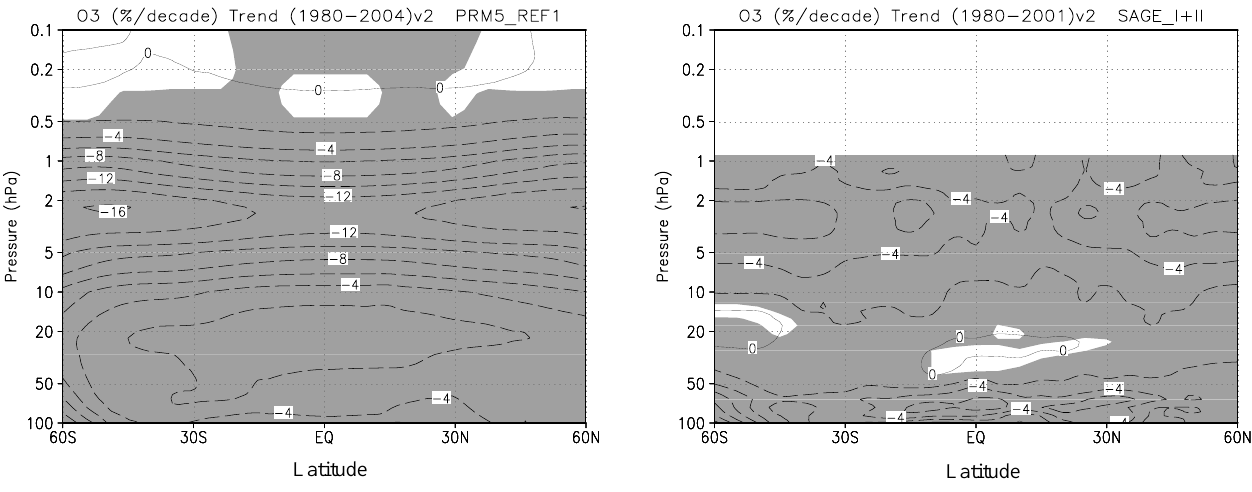
Latitude Latitude Fig. 10. Same as in Fig. 8 except that ozone is in %/decade with a contour interval of 2%/decade and the observation is SAGE I/II (Randel and WU, Fig.10 Same as in Fig. 8 except for that ozone is in %/decade with contour interval of 2 %/decade and the observation is SAGEI/II (Randel and WU, 2007).